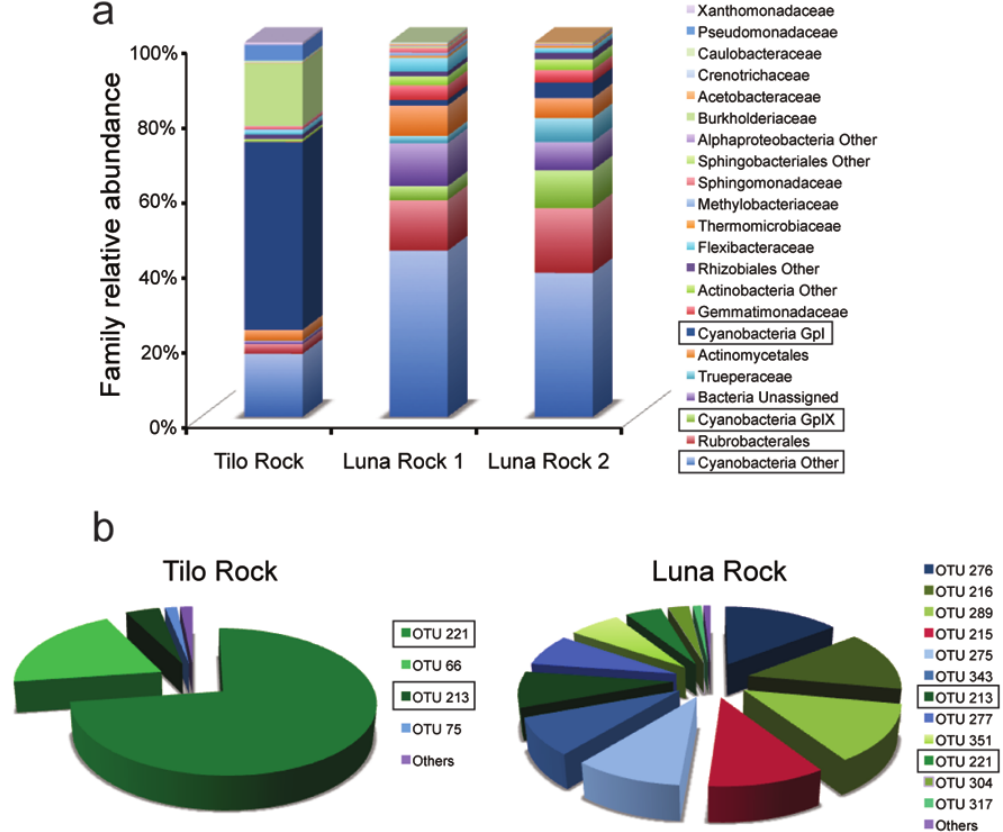
Fig. 4. Atacama rock community structure based on environmental 16S rRNA gene sequences from the Tilo and Luna rocks. (a) Relative abundance of major bacterial families ( > 10 counts summed across all samples); “other” are unidentified bacterial lineages; boxes are cyanobacterial families. (b) Relative abundance of Cyanobacteria OTUs ( > 5% cut off); boxes are common OTUs. Taxonomic assignments according to Table S2: green colours are Pleurocapsales ( Chroococcidiopsis ), blue colours are Nostocales , the colour red is Oscillatoriales , and the colour purple is “others” (taxa represented by < 1%). Analysis based on equally sized datasets (2622 sequence reads), randomly sub-sampled from Tilo and Luna Rock